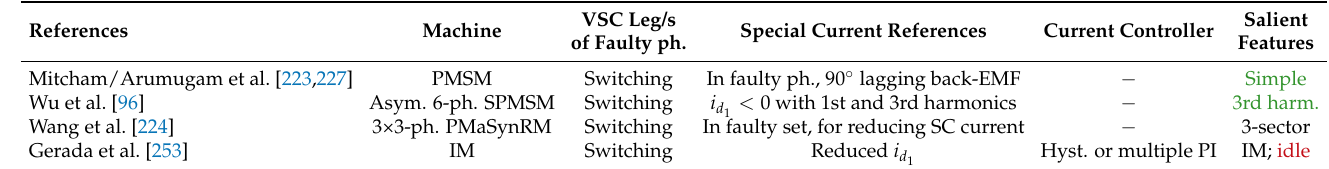
Table 13. Current control methods for reducing SC current under turn SCs (Section 5.3.3.2) in multiphase applications in the